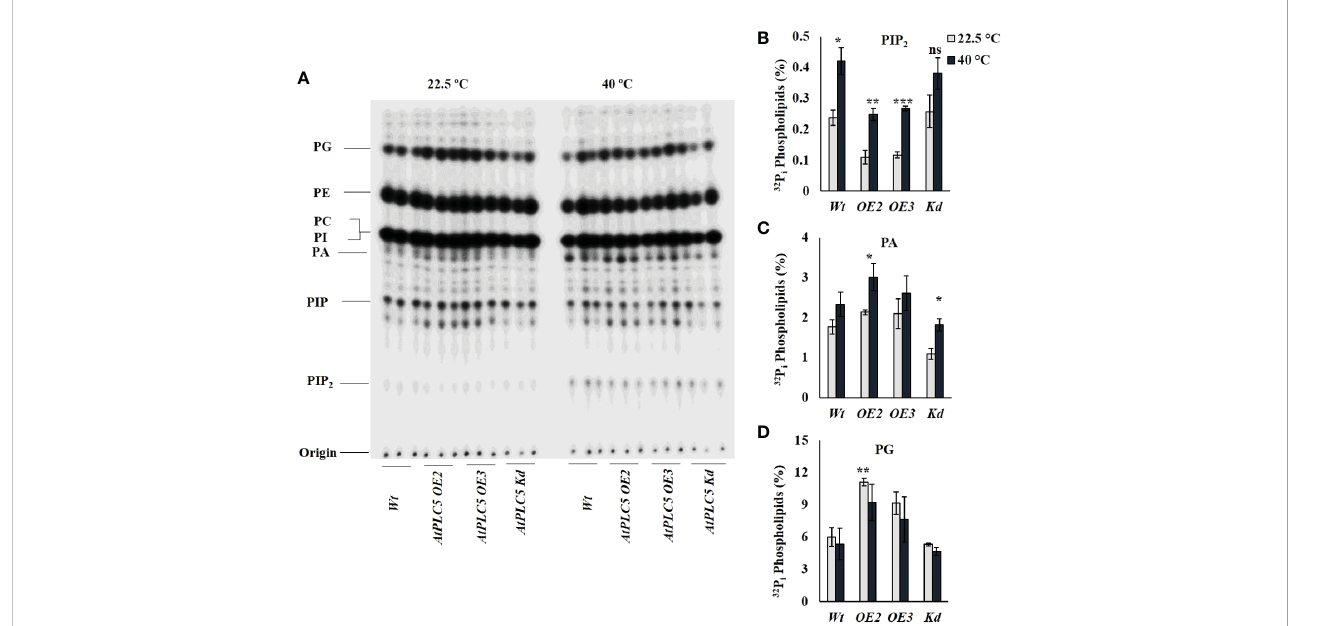
FIGURE 4 fi ling of PLC5 mutants under heat stress. Five days old seedlings were radioactively labeled O/N and treated for 30 min at high temperature 32 P i lipid pro (40 °C) using heat block. Lipids were then extracted, analyzed and quanti fi ed by phosphoimaging. (A) Typical TLC pro fi le of PLC5 mutants containing lipid extract of 3 seedlings each. (B) PIP 2 (C) PA (D) PG lipids behavior of Wt and PLC5 mutants under control and heat stressed condition. Data shown are the mean ± SE (n=3). Student's t -test (***P < 0.001) was used to test the level of signi fi